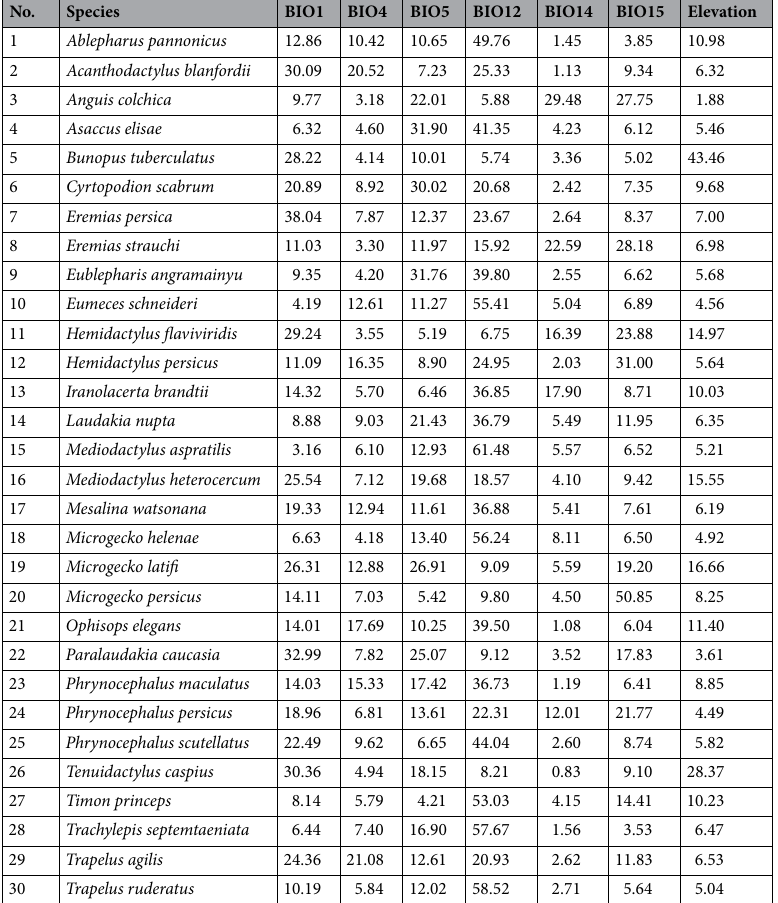
Table 2. Mean of variable importance (%) by the algorithms for the 30 lizard species in Iran. Annual mean temperature (BIO1); temperature seasonality (BIO4); the max temperature of the warmest month (BIO5); annual precipitation (BIO12); precipitation of driest month (BIO14); and precipitation seasonality